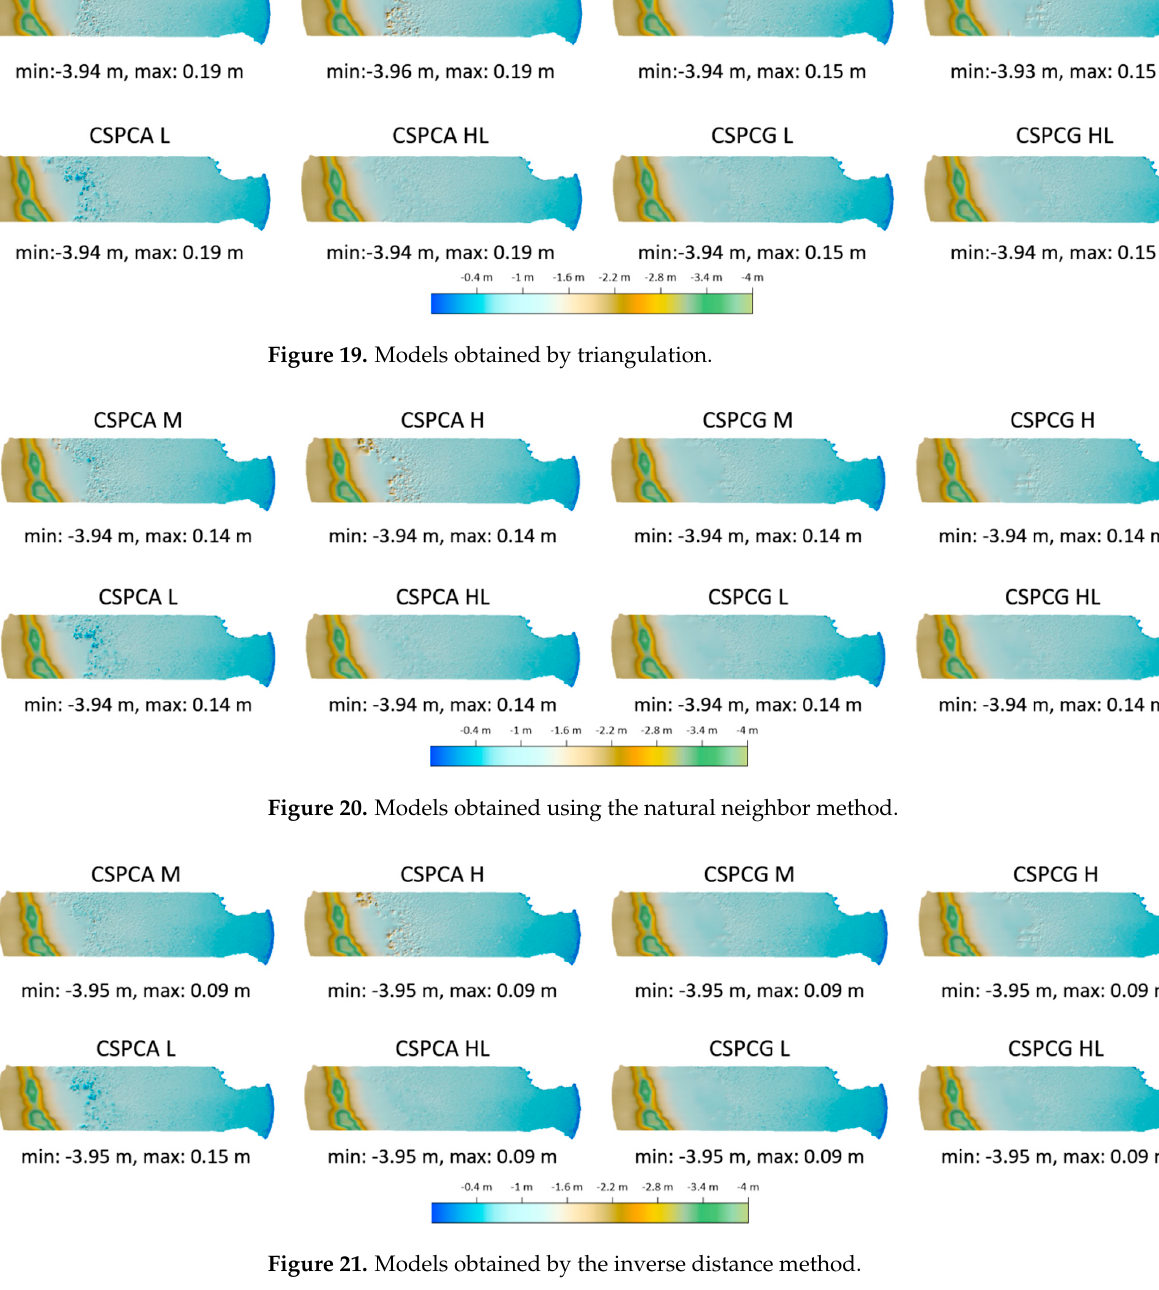
Figure 22. Models obtained by kriging. Figure 23. Models obtained by the RBF method. 3.2. Quantitative Analysis Quantitative analysis was performed using points extracted from the USV survey data set, which included 56 points, distributed evenly across the test area. For the quantitative analysis, the methods chosen were IDW, KRI, NAN, and TRI, which allow correct surface reconstruction. For each generated surface from the test data set, the difference between the heights of the test points and the corresponding points located on the surfaces of the developed digital surface model was calculated. The maximum error (MaxE), the minimum error (MinE) and the mean error (ME) were calculated for each analyzed case according to Equation (1):